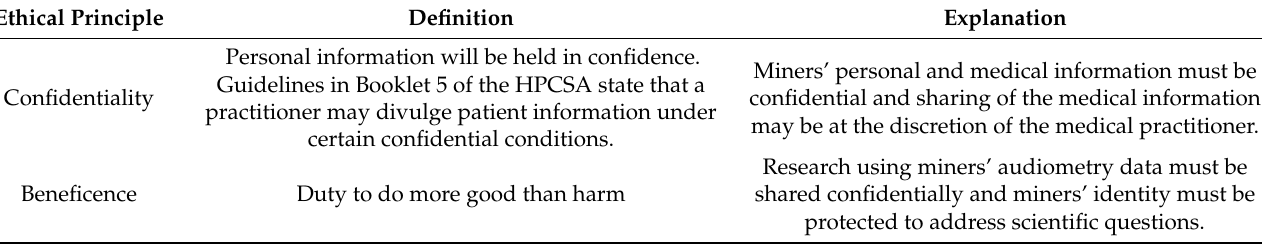
Table 1. Summary of ethical